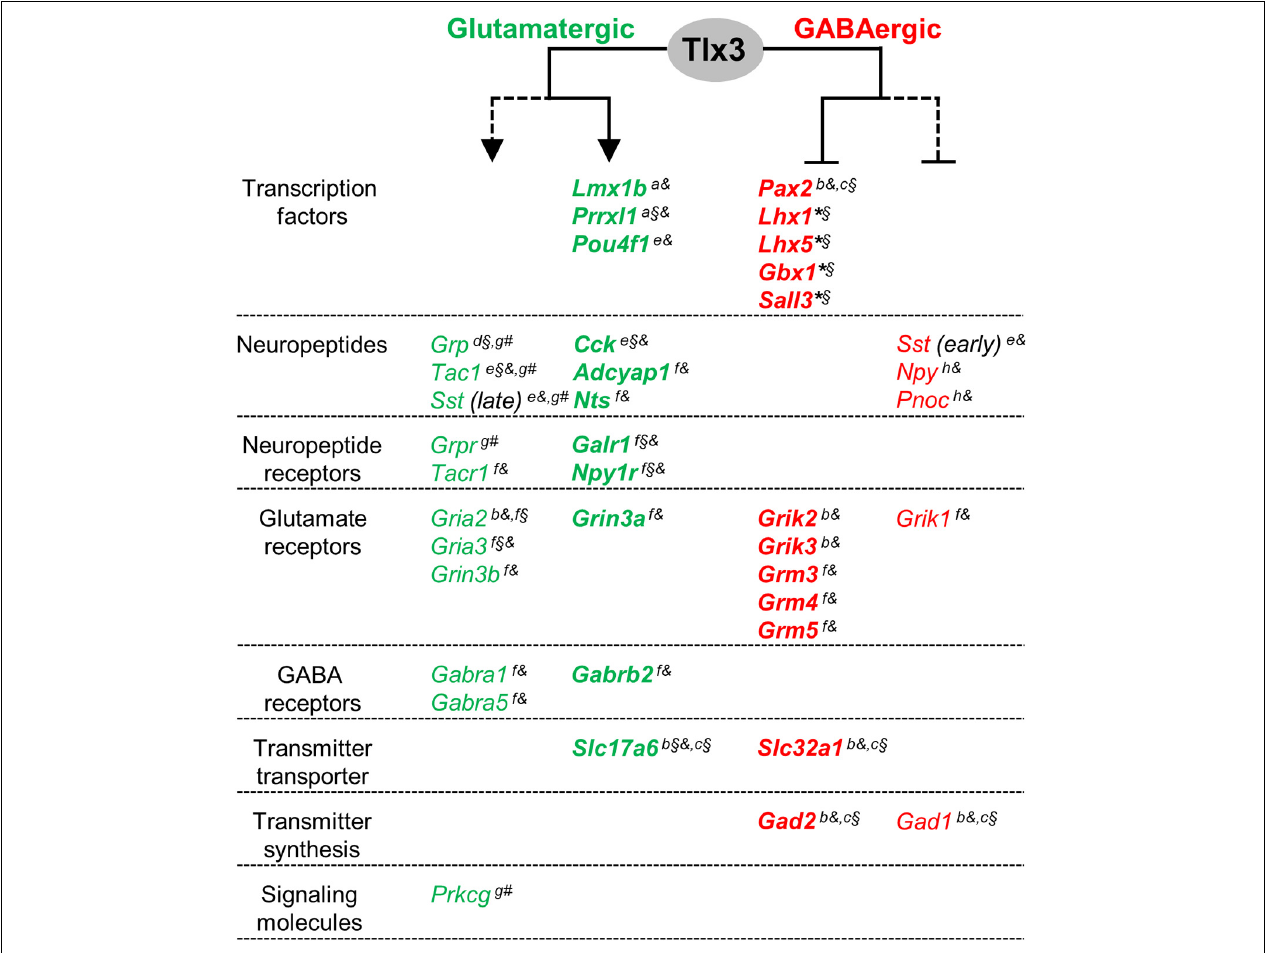
FIGURE 5 | A model for a dual activity of Tlx3 in promoting glutamatergic, while concomitantly suppressing GABAergic specification program in dILB neurons. Tlx3 direct target genes include transcription factors, neuropeptides, neuropeptide and glutamate and GABA receptors, and molecules for neurotransmitter transport. Genes expressed in glutamatergic cells, most of which are Tlx3 + /Pax2 − -cells, are markedly reduced or eliminated in Tlx3 knockout mice, whereas genes expressed in GABAergic cells, most of which are Tlx3 − /Pax2 + -cells, are upregulated in Tlx3 knockout mice. Expression data was retrieved from the following reported studies: Qian et al., 2002 (a), Cheng et al., 2004 (b), Cheng et al., 2005 (c), Li et al., 2006 (d), Xu et al., 2008 (e), Guo et al., 2012 (f), Xu et al., 2013 (g), Huang et al., 2008 (h), and our study (*) using Tlx3 single knockout (§), Tlx1/3 double knockout (§), and/or Tlx3 conditional knockout (#) mice. Line, direct regulation; dashed line,